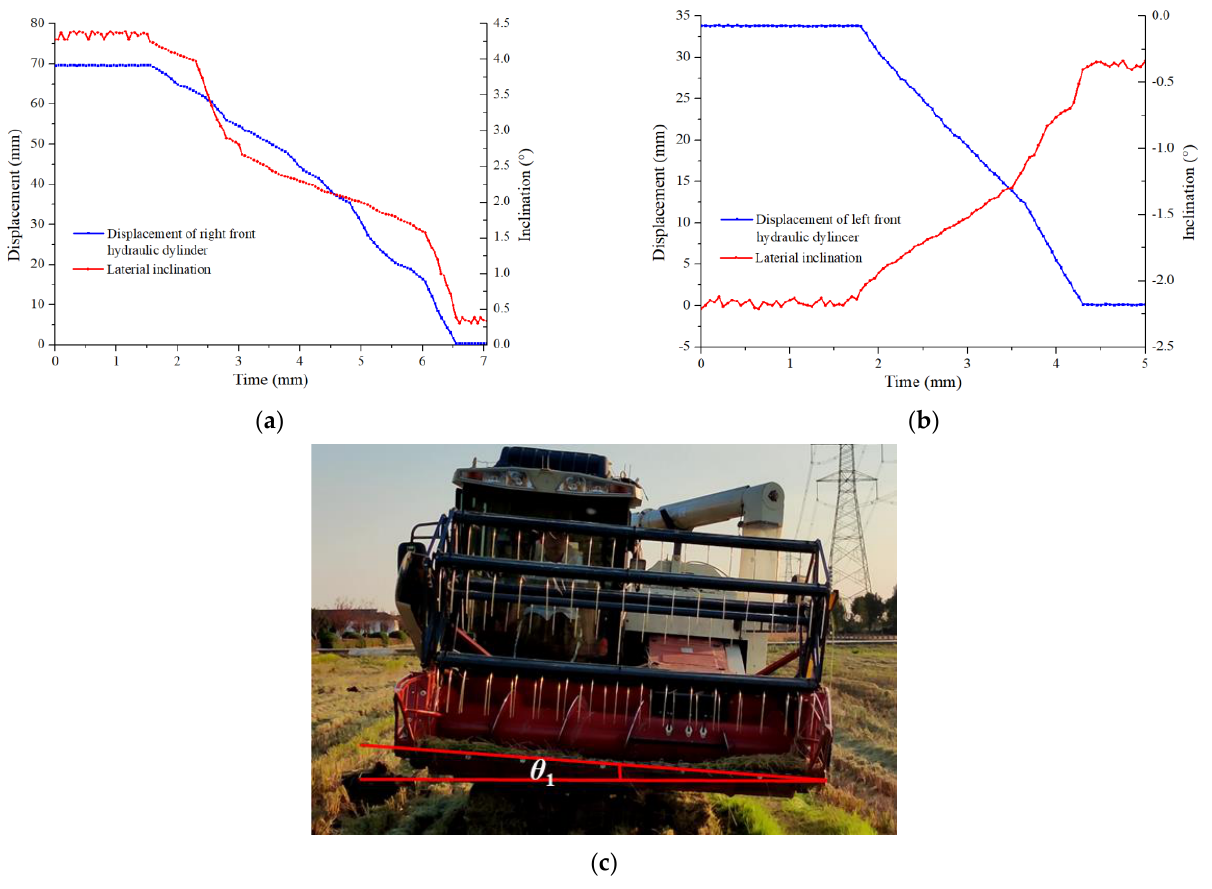
Figure 13. Vehicle lateral leveling test of combine harvester. ( a ) Vehicle adaptive leveling after extreme left tilt. ( b ) Vehicle adaptive leveling after right tilt. ( c ) Vehicle lateral leveling test in the field.